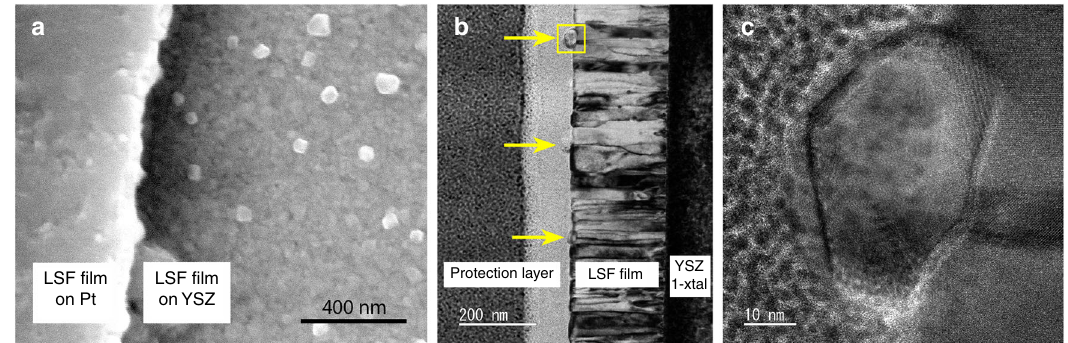
Fig. 6 Electron microscopic images of La 0.6 Sr 0.4 FeO 3- δ thin fi lms ca. 60 h after initial exsolution. a Scanning electron microscopy image (secondary electron detector). The bright spots are the exsolved particles with an average diameter of 54 nm (standard deviation 16 nm). b Transmission electron microscopy bright fi eld image of the fi lm cross section. The marbled appearance of the columnar fi lm is due to diffraction contrast. Exsolved particles are marked by arrows, the particle in the box is magni fi ed in ( c ), which shows a high resolution image of this region. The slightly blurred looking halo-like fringe around the particle is due to magnetic interaction of the particle with the